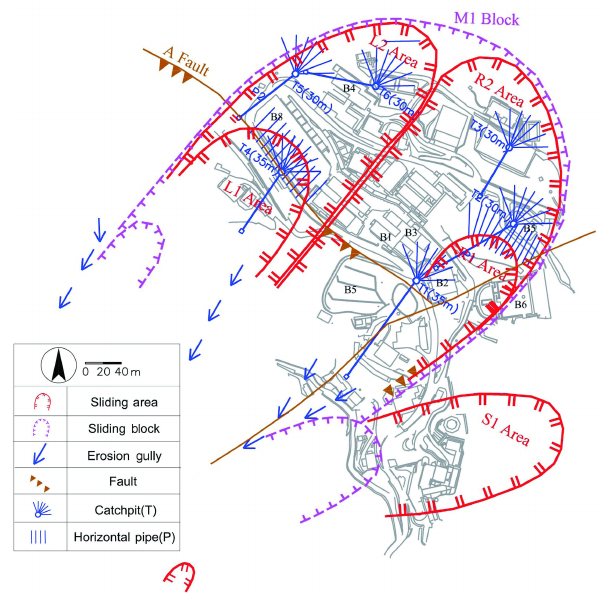
Figure 20. Locations of the catchpits within the campus.